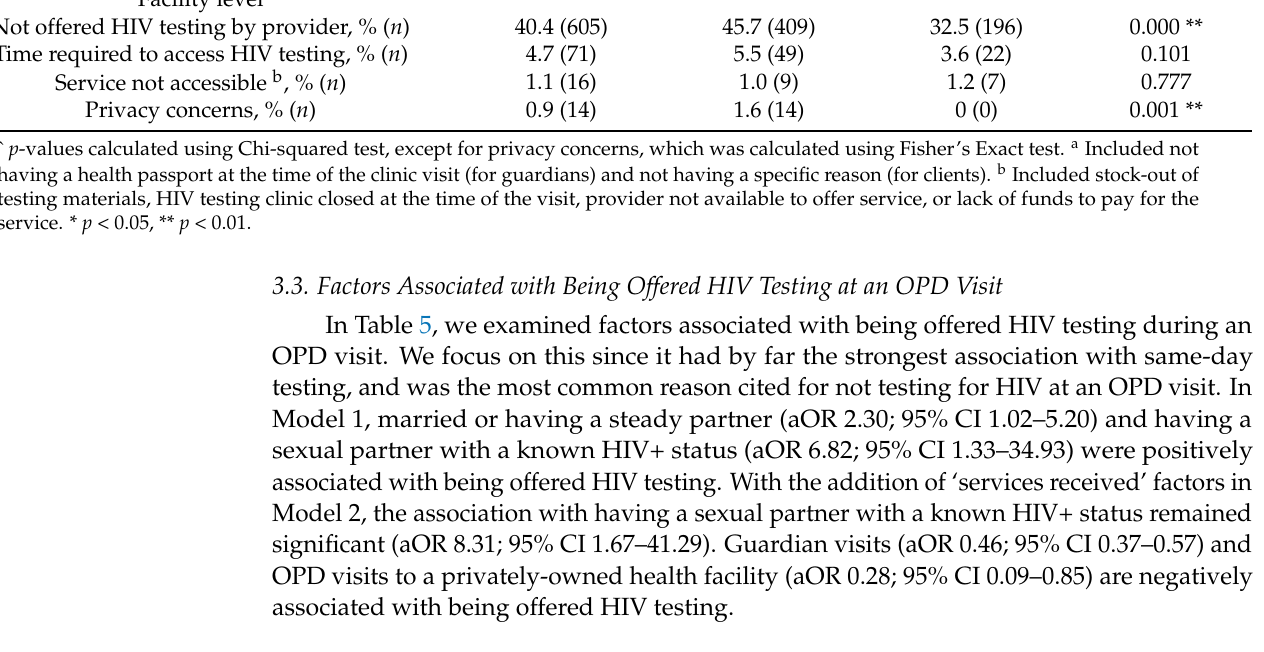
Table 5. Multivariate logistic regressions of factors associated with offered HIV testing at a clinic